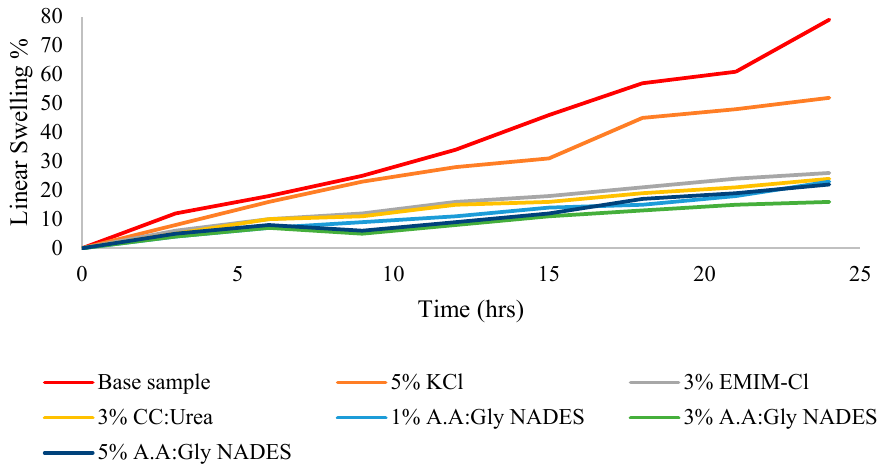
Figure 7. Linear swelling of wafer caused by various inhibitors in drilling mud.